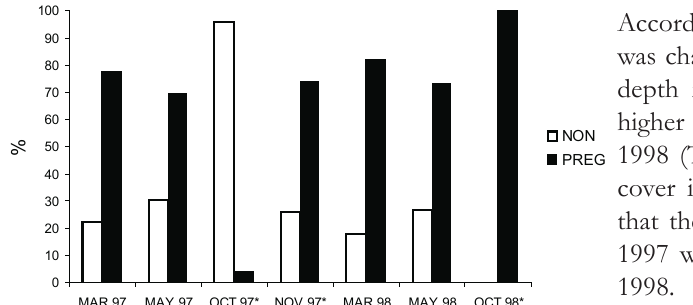
Fig. 2. Mean (SE) body mass within month and quartile of the Seiland reindeer herd ( Rangifer t. tarandus ). The data were divided into quartiles, according to the body mass distribution within each month, each year.